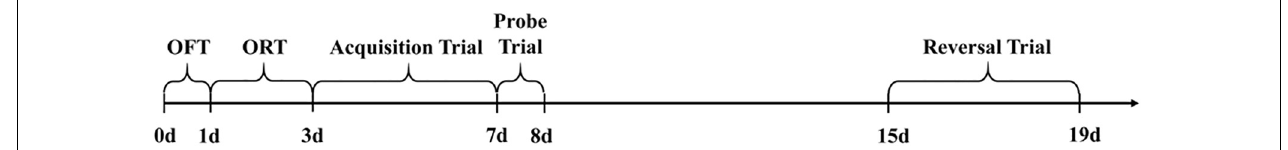
FIGURE 1 | Time-line of the behavioral